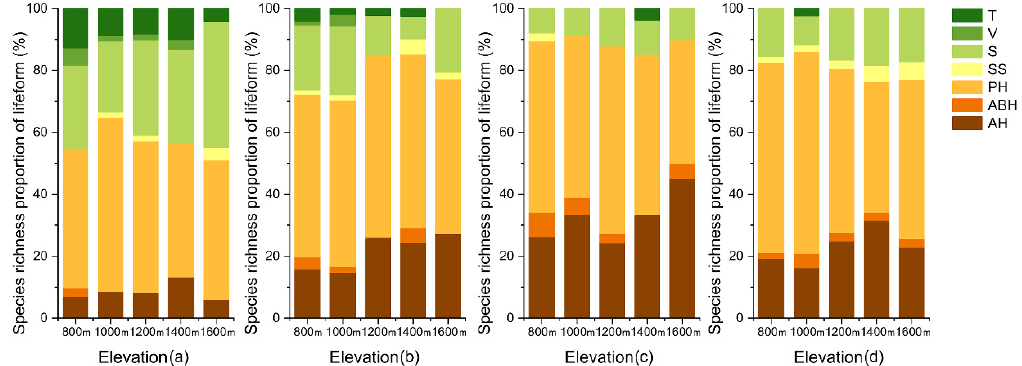
Figure 4. Species richness proportion of lifeform in understory vegetation ( a ) and soil seeds in April ( b ), July ( c ) and October ( d ) with elevation. T = tree, V = vine, S = shrub, SS = semi-shrub, PH = perennial herb, ABH = annual–biennial herb, AH = annual herb.